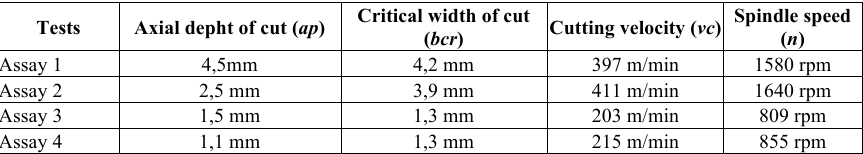
Table 1. Cutting parameters for tests